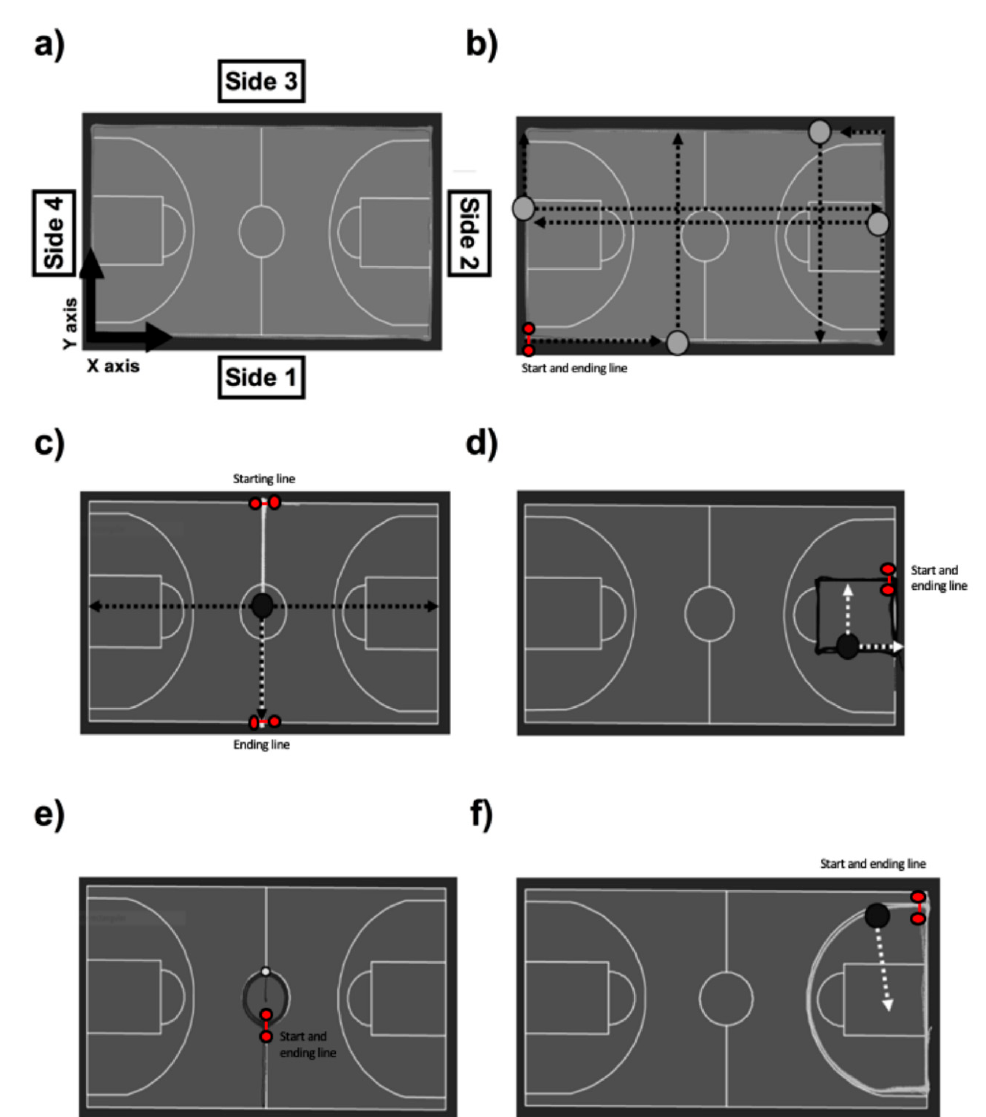
Figure 4. ( a ) Arrangement of sides and axes for the analysis of the movements made by participants and design of the different routes followed: ( b ) Perimeter markings of court, ( c ) middle line of court; ( d ) exterior perimeter of the painted lines, ( e ) center circle and ( f ) 6.75 m line.